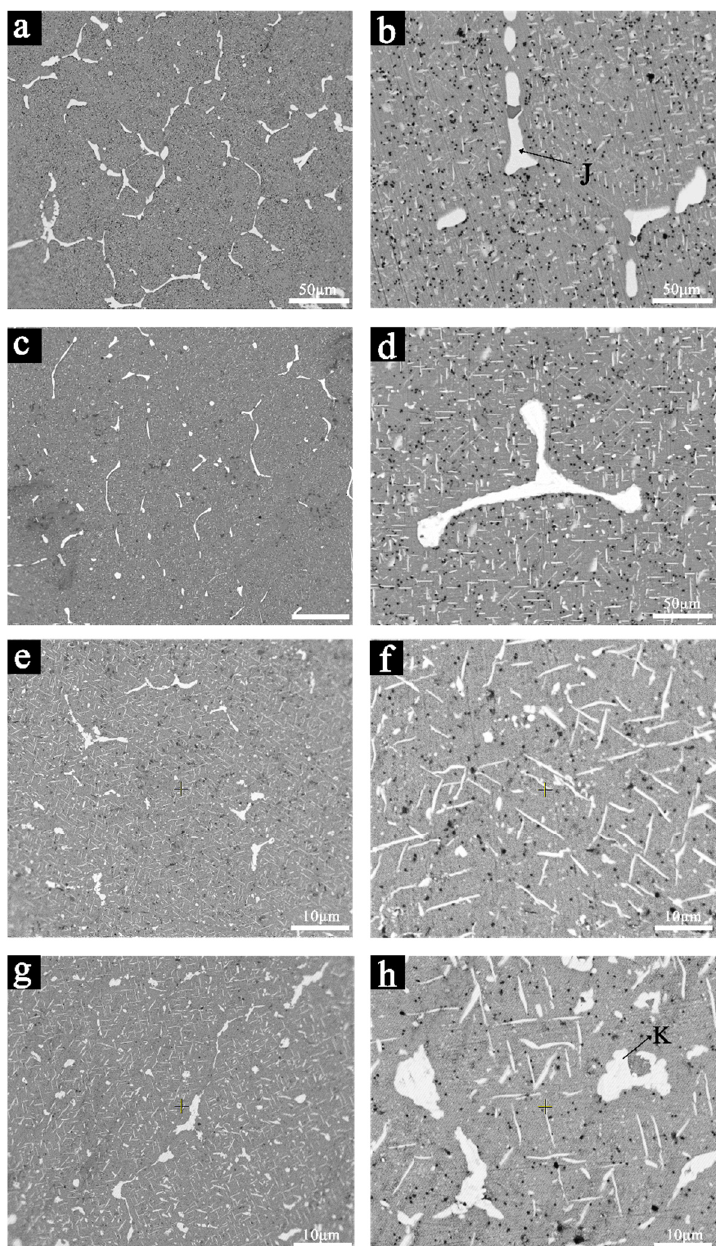
Figure 2. Backscattered SEM images of the as-homogenized alloys: relative low-magnification and microstructure of the alloys as-homogenized at ( a , b ) 500°C for 8 h, ( c , d ) 515°C for 8 h, ( e , f ) 500°C for 20 h, and ( g , h ) 515°C for 20 h.